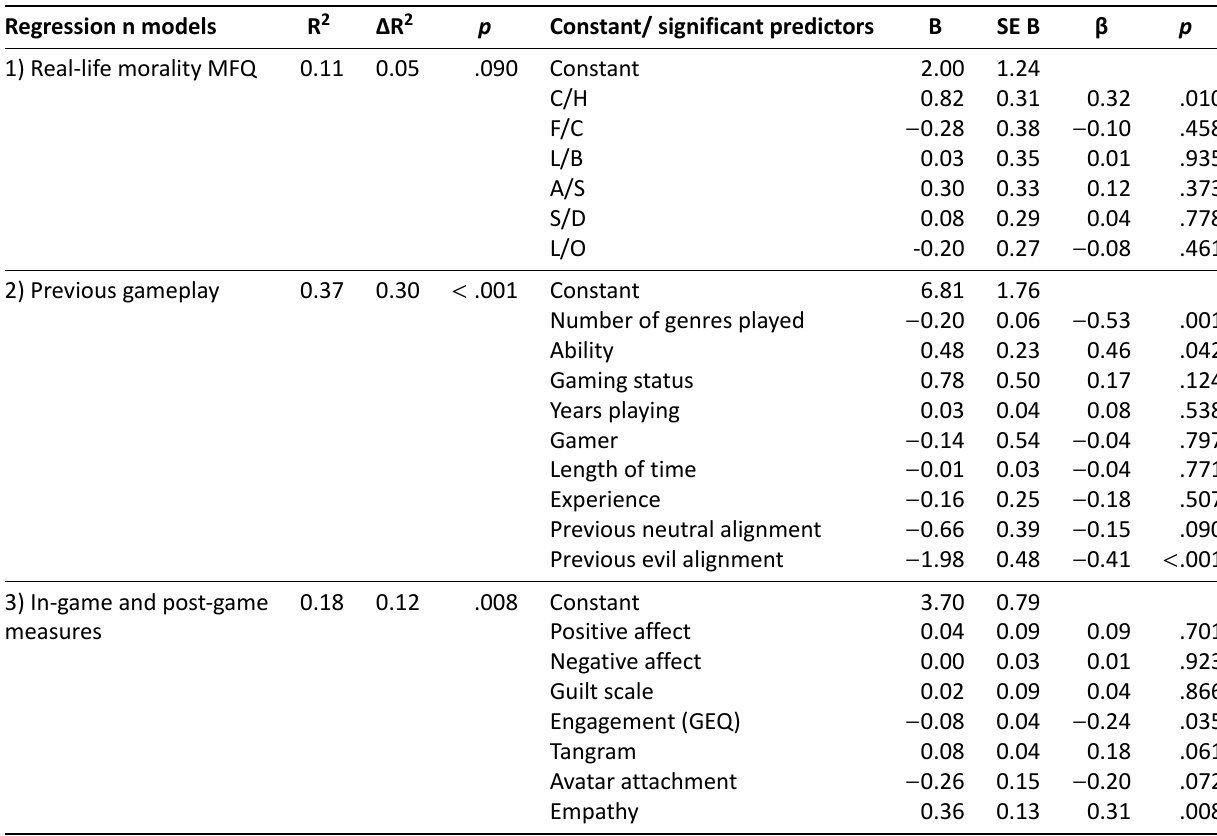
Table 3. The three multiple linear regression models with in-game moral alignment. Regression n